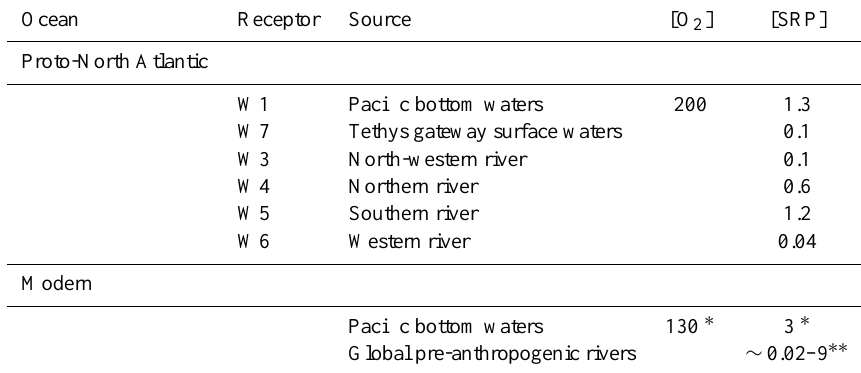
Table 2. Initial concentrations of SRP and oxygen (µmolL − 1 ) in waters entering the proto-North Atlantic from the Pacific Ocean, the Tethys gateway and rivers. For comparison, concentrations in modern Pacific bottom waters and the range of SRP concentrations in pre- anthropogenic rivers are also given. SRP concentrations in rivers entering boxes W3 and W4 are within the range for the North American rivers. The SRP concentration for the riverine input in W5 is based on that of the Amazon. The low SRP input from the western river is based on climatic constrains for the